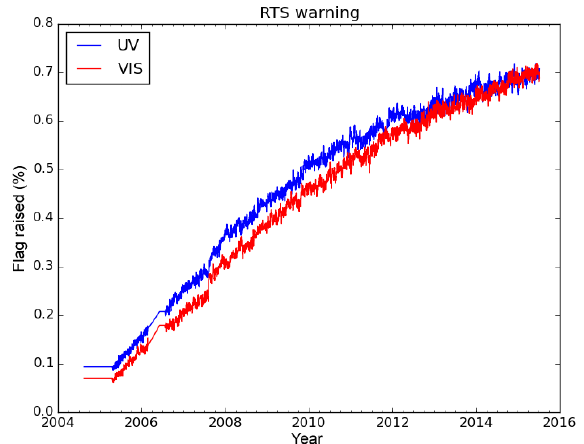
Figure 17. The wavelength- and time-binned solar irradiance SNRs for January 2005 (full lines) and January 2016 (dots) in UV1 (black), UV2 (blue) and VIS (red) channels.